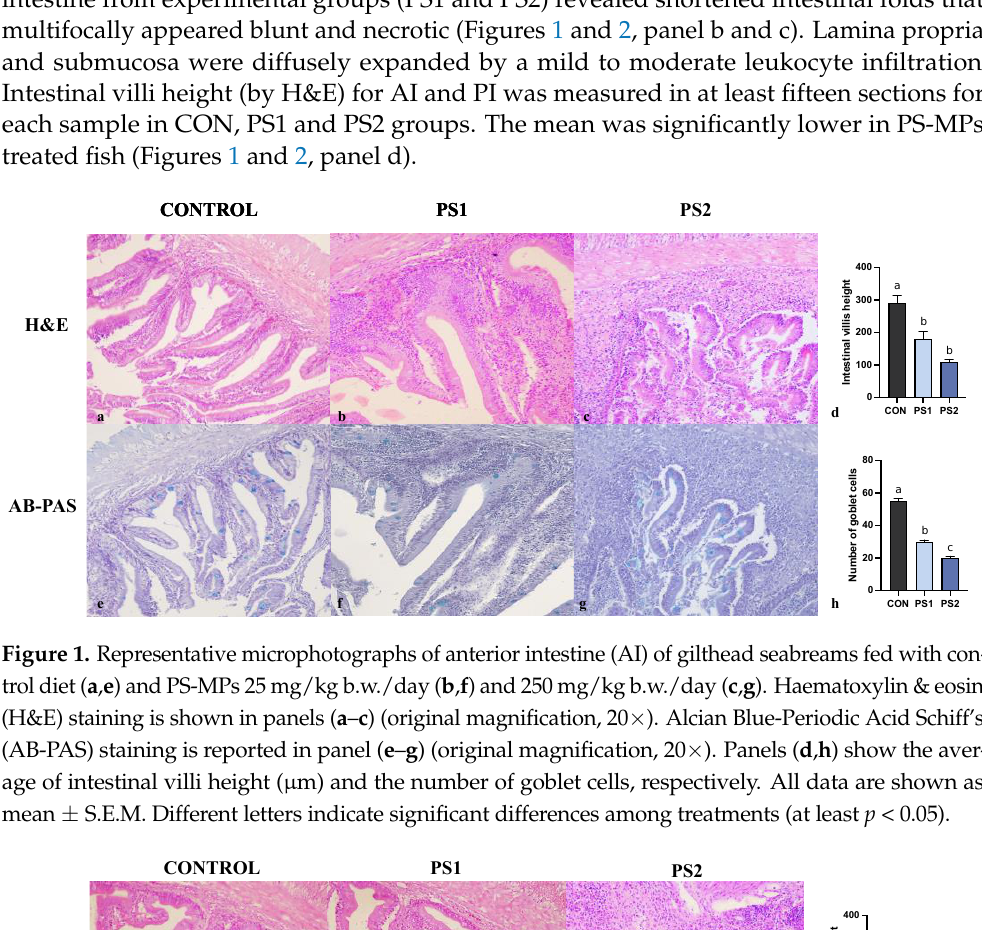
. Figure 3. The oxidative stress induced by PS-MPs in the gut of gilthead seabreams. ( a , c ) ROS and ( b , d ) MDA levels were measured in the anterior (AI) and posterior intestine (PI), respectively. All data are shown as mean ± S.E.M. Different letters indicate significant differences among treatments (at least p < 0.05).